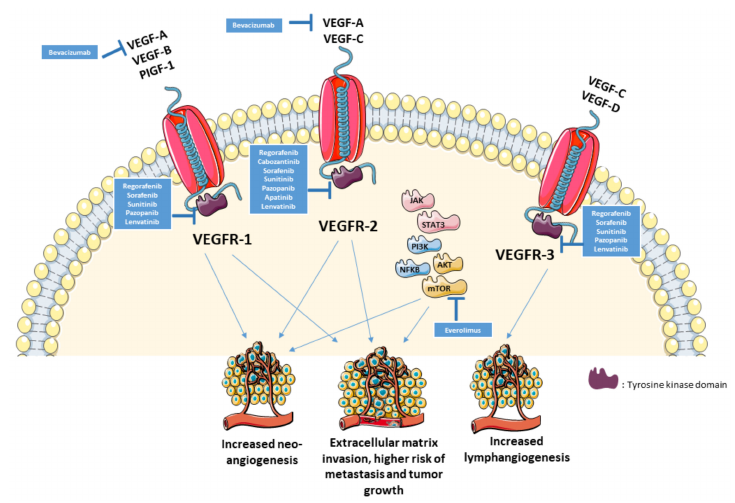
Figure 1. VEGF pathway in osteosarcoma and potential therapeutic